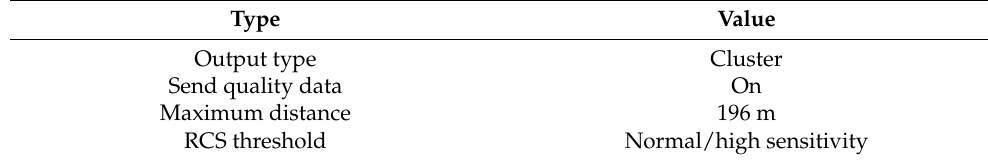
Table 1. Basic radar sensor setup, Continental ARS-408.